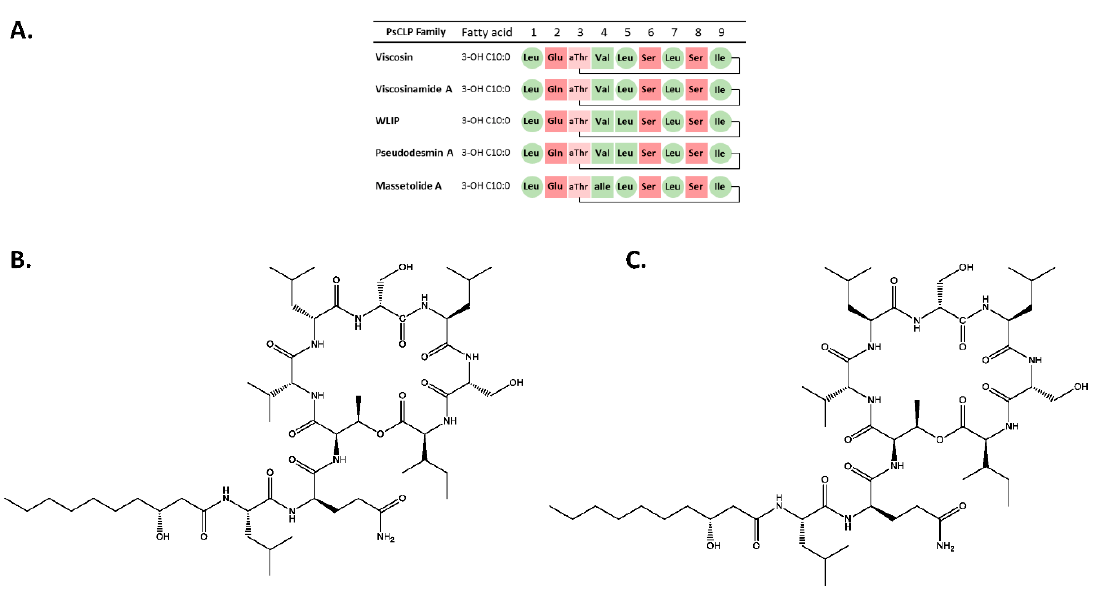
Figure 1. Chemical structure of pseudodesmin and viscosinamide. ( A ) Sequence comparison with other cyclic lipopeptides (CLPs) of the Viscosin group; PsCLP: Pseudomonas CLP. ( B ) Chemical structure of the major isolated CLP of Pseudomonas sp. COR52, identified as pseudodesmin A; ( C ) Chemical structure of the major isolated CLP of Pseudomonas sp. A2W4.9, identified as viscosinamide A. Hydrophobic amino acids are indicated in green, hydrophilic amino acids are indicated in pink. d -amino acids are square-shaped, while l -amino acids are circled.